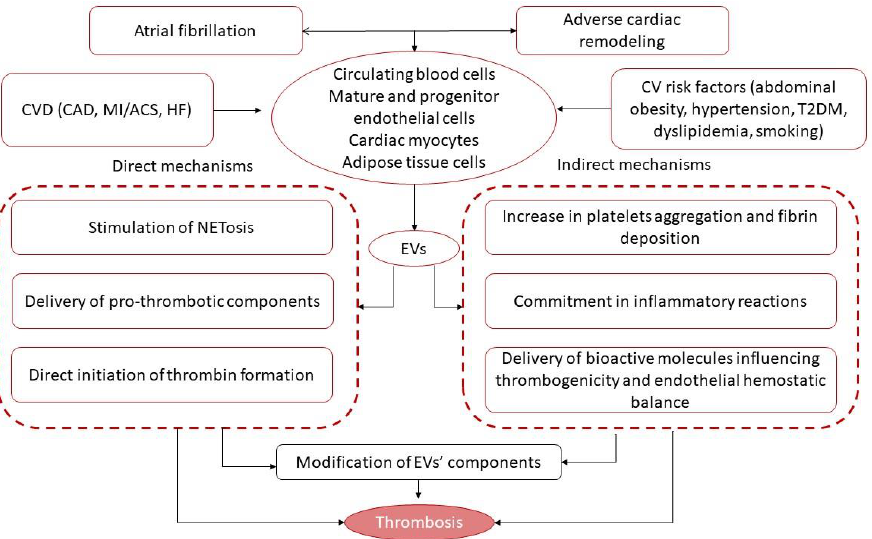
Figure 2. Pathogenetic pathways underlying EV-related thrombosis formation and increase in thrombogenicity. Abbreviations: CAD, coronary artery disease; ACS, acute coronary syndrome; EVs, extracellular vesicles; NETosis, neutrophil extracellular traps; AF, atrial fibrillation; CVD, cardiovascular diseases; CV, cardiovascular; HF, heart failure; T2DM, type 2 diabetes mellitus.